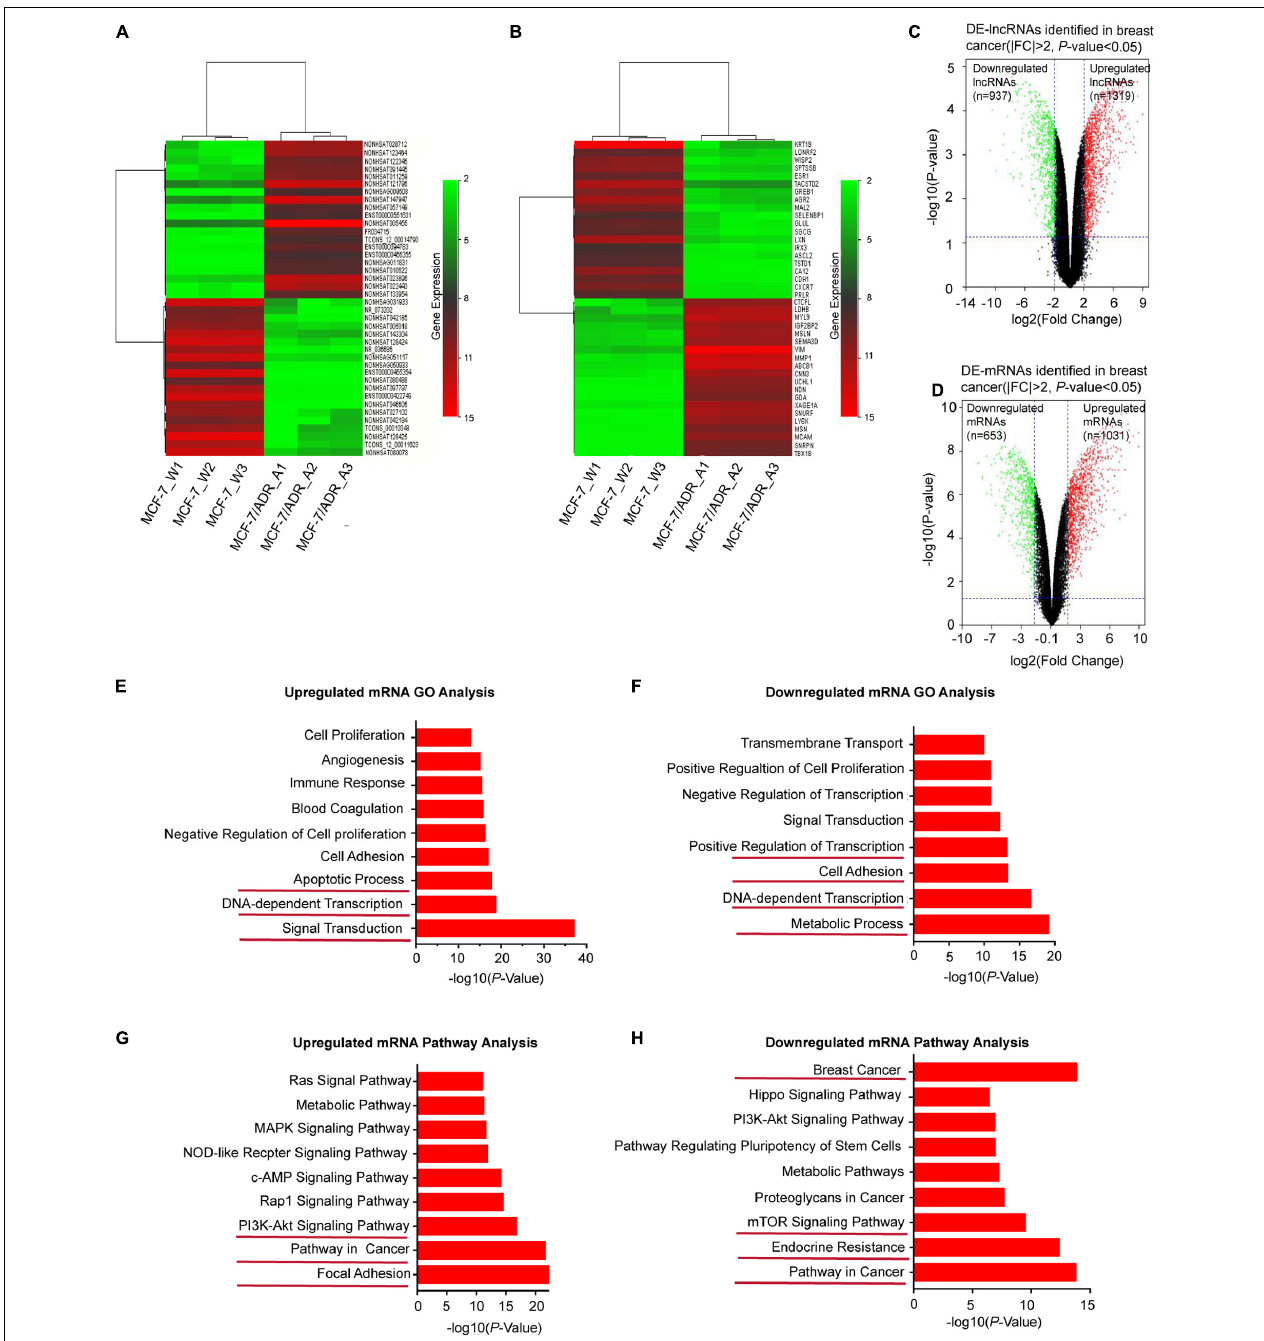
FIGURE 1 | Overview of DE-lncRNAs and DE-mRNAs between MCF-7/ADR and MCF-7 cells in preparation of functional enrichment analysis. Heat map and hierarchical clustering of the top differentially expressed lncRNAs (A) and mRNAs (B) shared among the two group profiles (MCF-7/ADR and MCF-7 cells) in three biological replicates. The x-axis represents the sample names, and the y-axis represents different genes. Red indicates that a differentially expressed gene has a high expression value in the grouped sample, and green indicates that a differentially expressed gene has a low expression value. The top 40 DEGs are shown in the map according to the FCs. The magnitude of deviation from the median is represented by the color saturation. (C) Volcano plot showing all DE-lncRNAs in breast cancer. A total of 1319 significantly upregulated genes (red dots) and 937 downregulated genes (green dots) are highlighted for each time point (| FC| > 2, P < 0.05). (D) Volcano plot showing all DE-mRNAs in breast cancer. The red dots represent 1031 upregulated-mRNAs, while green dots represent 653 downregulated mRNAs (|FC| > 2, P < 0.05). (E) GO enrichment analysis of upregulated mRNAs. (F) GO enrichment analysis of downregulated mRNAs. The bar graphs represent the enrichment of these mRNAs. The value of (-logP) is the negative logarithm with base 10 of the P value. The threshold of significance was a P < 0.05, and the FDR was calculated to correct the P -value. (G) KEGG pathway enrichment analysis for upregulated mRNAs. (H) KEGG pathway enrichment analysis for downregulated